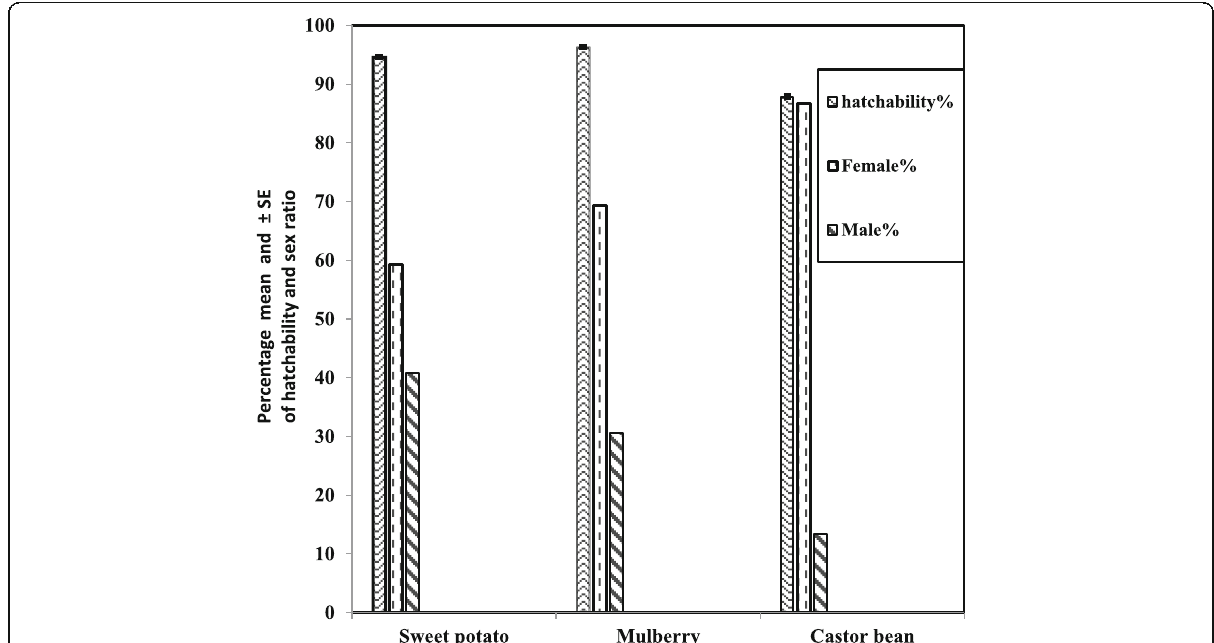
Fig.2 Influence of different host plants on hatchability, and sex ratio of Tetranychus